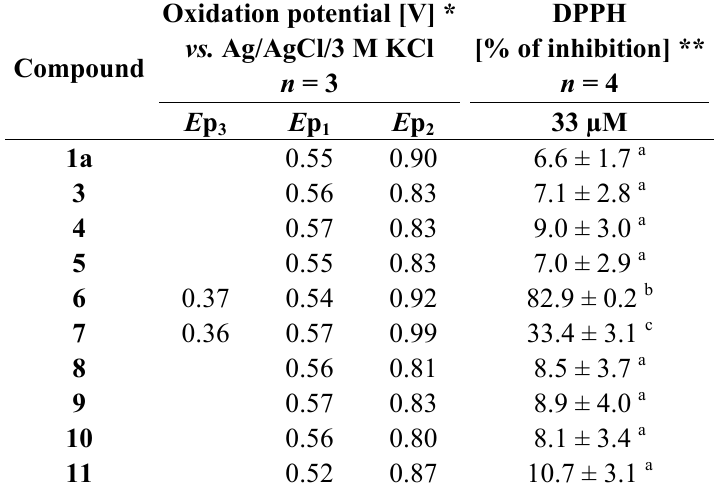
) and DPPH scavenging for monomeric flavonolignans p